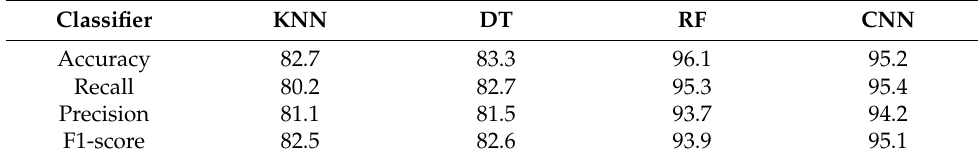
Table 4. Phase 1: Continuous authentication results for Scenario B: single point-and-click action.